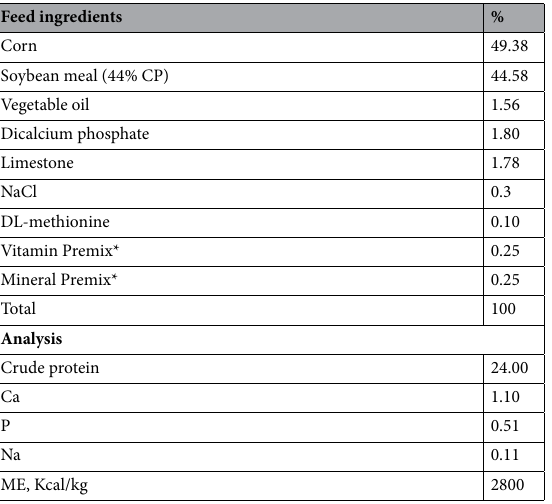
Table 3. Ingredients and chemical composition of diet during the experimental period (0–35 days). *Vitamin/ Mineral Premix (Talavang company, Tehran, Iran) supplied per 5 kg: vitamin A, 11,000,000 IU;